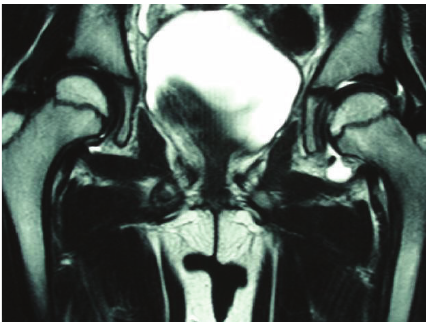
Figure 2: Coronal, T2-weighted magnetic resonance imaging scan at the initial visit. No abnormal findings, except left hip joint effusion, were observed.